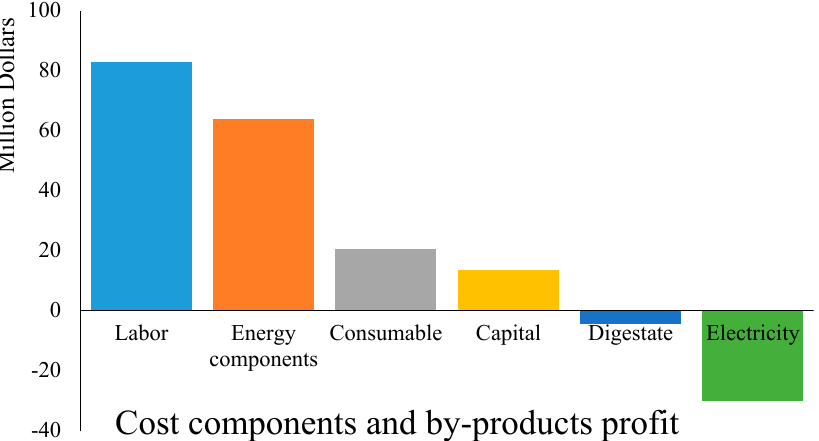
Figure 2. Separation of costs by major component for 95 ML ethanol production annually and anaerobic digestion of residuals. Negative costs actually mean profit (e.g., digestate and electricity).